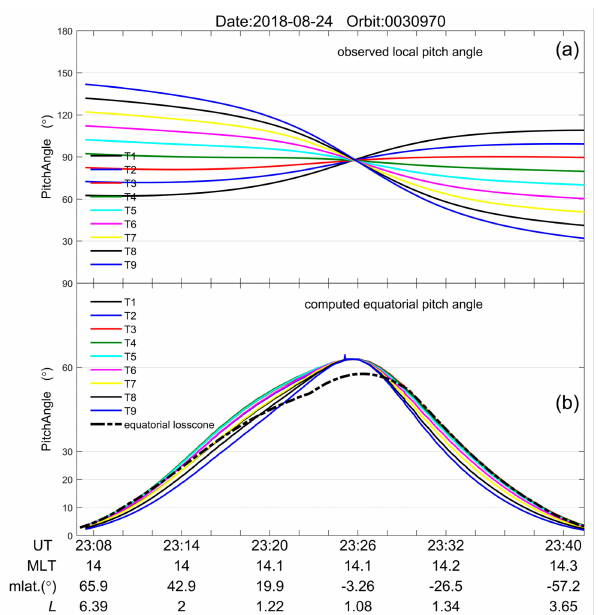
Figure 10. The comparison between the observed local pitch angels ( a ) and the computed equatorial pitch angles ( b ) for orbit No. 0030970 on 24 August 2018. The thick dashed line in ( b ) displays the equatorial loss cone (see text). T1–T9 with different colors in the legend denote the results from the nine silicon-slice units of HEPP-L onboard the